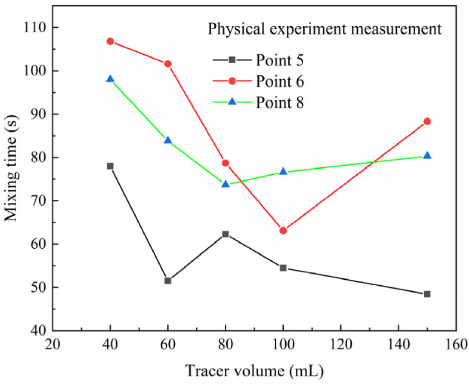
Figure 5. Comparison of the mixing time of different dosages of KCl solution in the water model.